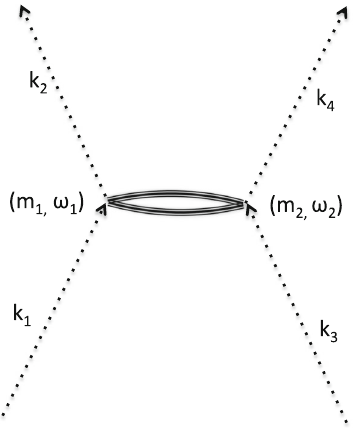
Fig. 4 Thecirculardiagramcontributetothenon-analyticcomponents of the potential